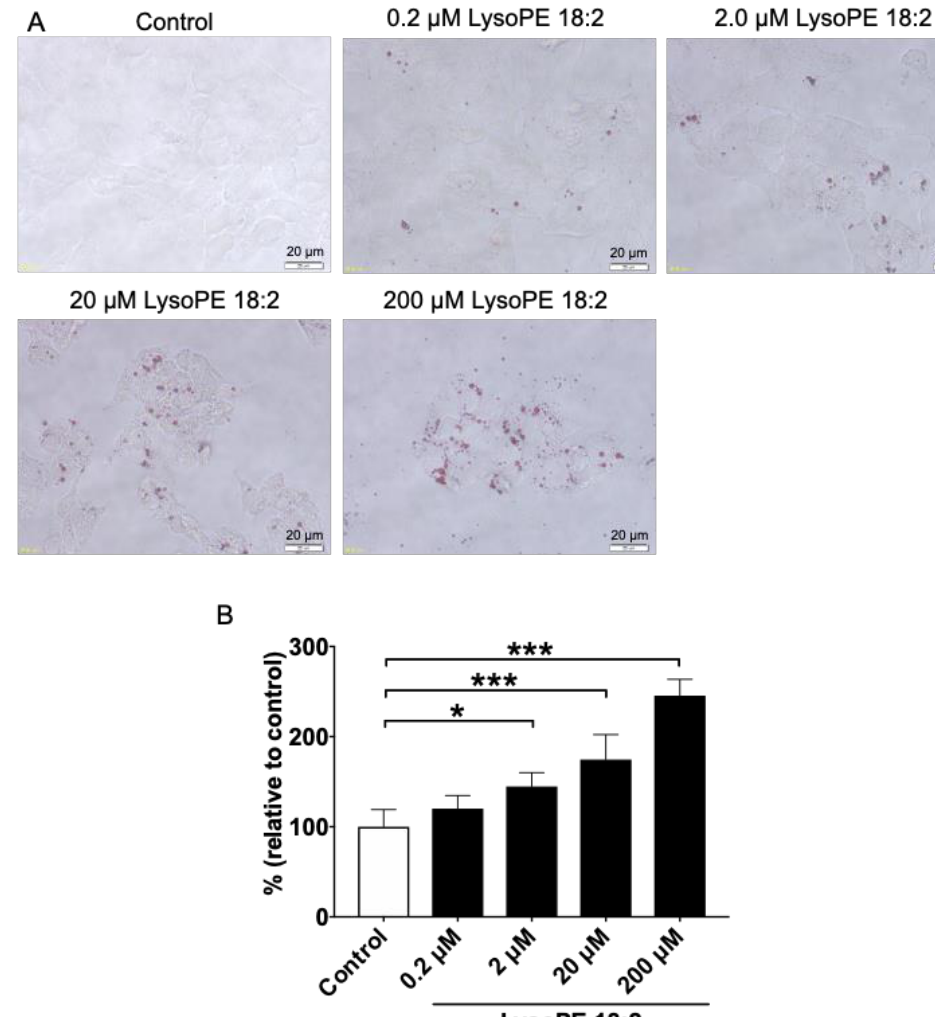
Figure 2. Oil Red O staining and evaluation of lipid accumulation. ( A ) Lipid droplets formed by C3A cells supplemented with 0.2–200 µ M lysoPE 18:2 (40 × ). ( B ) Quantification of lipid accumulation, as measured by the absorbance of extracted Oil Red O dye. Absorbance in the control group was set as 100%. Results were expressed as mean ± standard deviation. n = 4. * p < 0.05, *** p < 0.001.